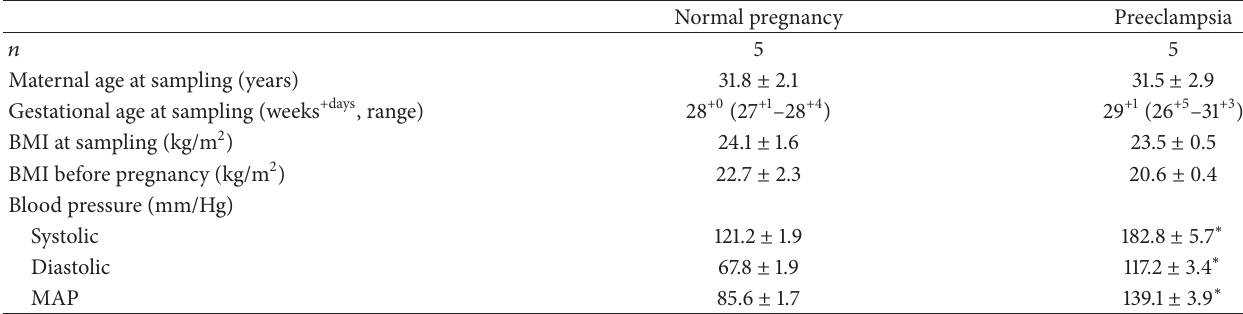
Table 1: Characteristics of the study population of the sera. Normal